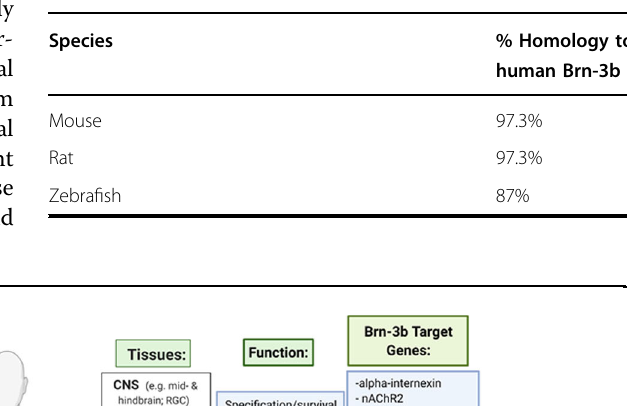
Table 1 Comparison of Brn-3b amino acid homology between human and rodents (mouse and rat) and zebra fi sh.